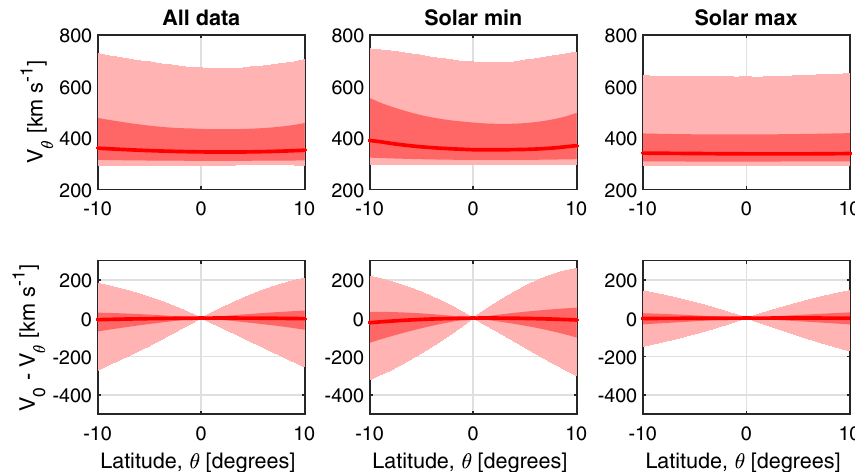
Fig. 3. Same as Figure 2, but only showing latitudes between (cid:3) 10 (cid:1) and 10 (cid:1) .